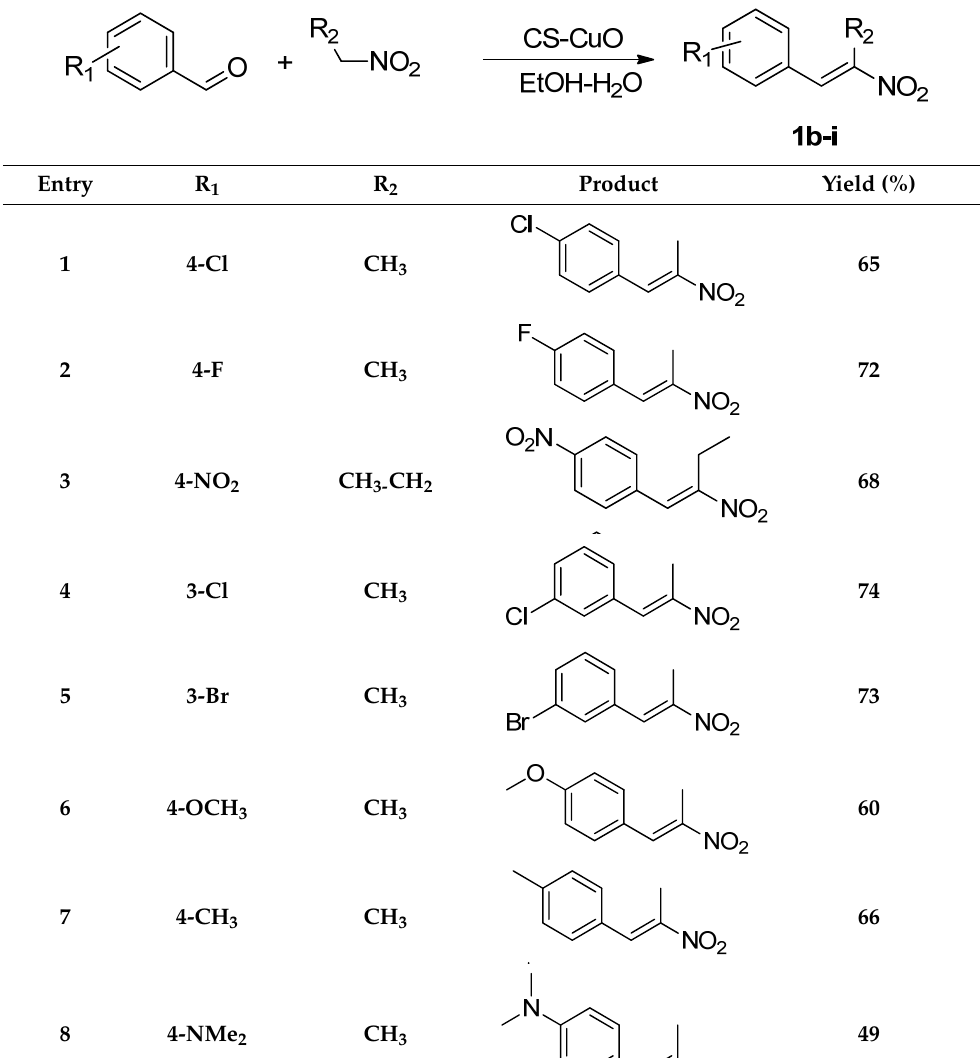
Figure 6. Recyclability of CS-CuO (15 wt.%) nanocatalyst in synthesis of product 1a . By summing up the data from the optimization, the best result was obtained by em- ploying CS-CuO (15 wt.%), at 120 °C for 3 h in (1:5) EtOH-H 2 O as the solvent.